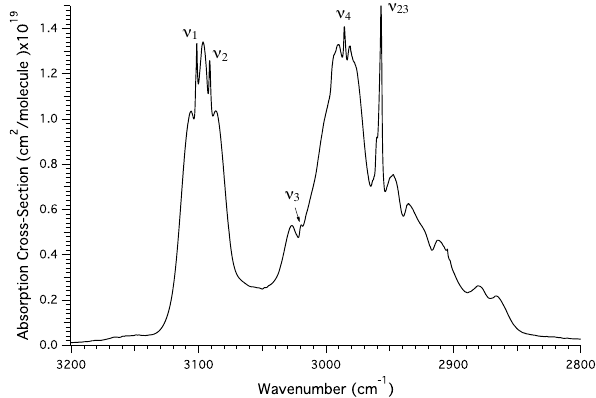
Figure 3. Quantitative infrared spectrum showing the CH stretch region of isoprene. Absorption cross sections are given in Nape- rian units (cm 2 molecule − 1 ) × 10 19 for the composite spectrum recorded at 298K.